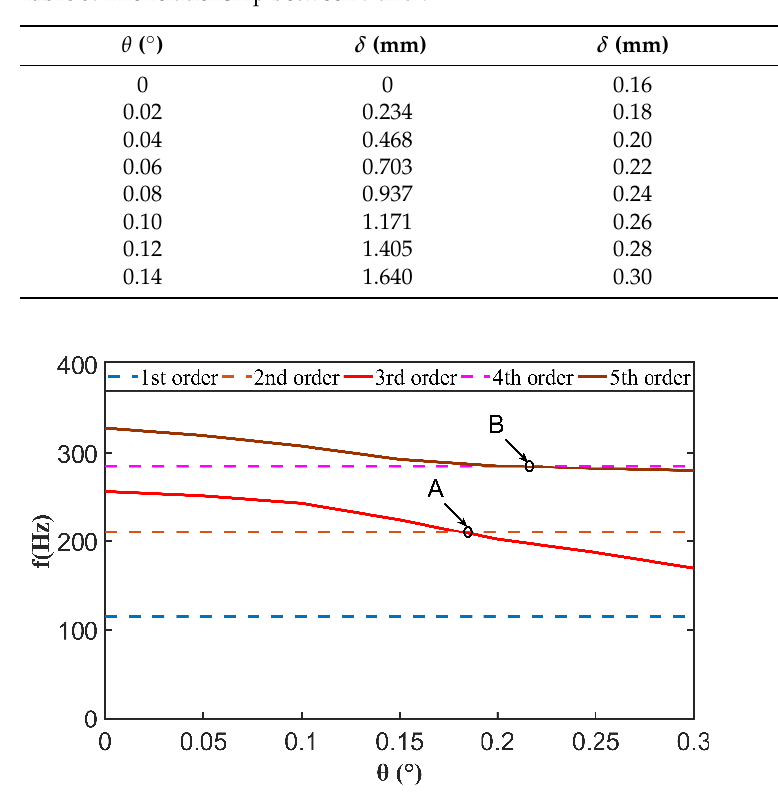
Figure 16. Variation trend of natural frequency of front deflection angle non-concentricity in the range of 0°–0.3°. Table 6. The change rate of the natural frequency of the 3rd order. Decentraction ( ◦ ) Natural Frequency